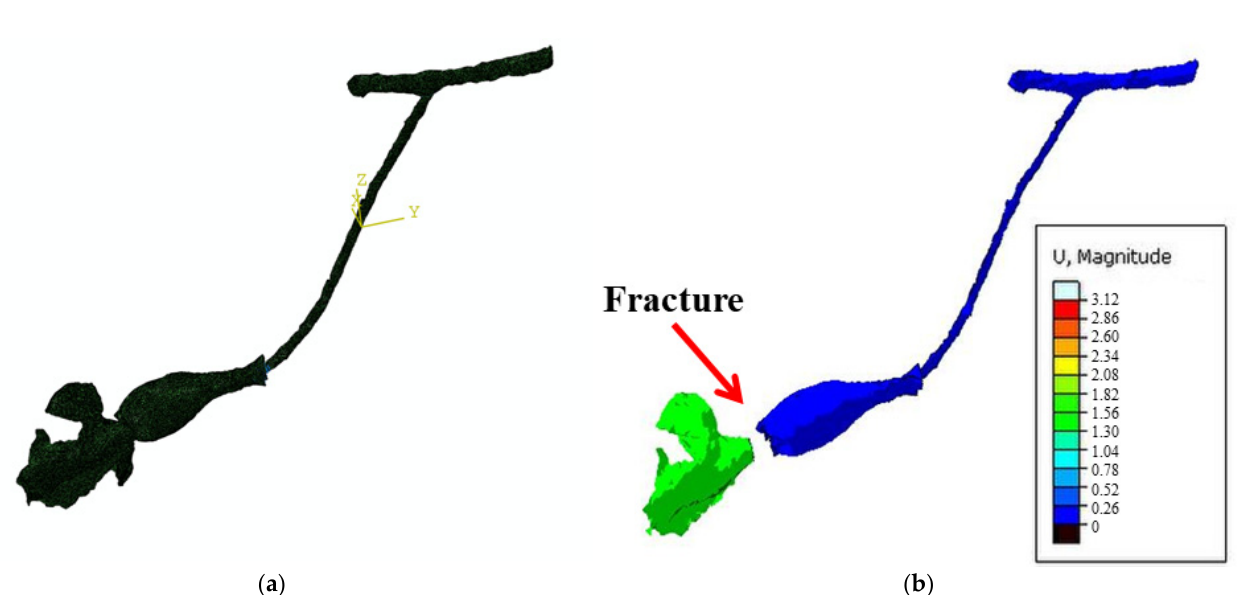
Figure 5. The meshed model ( a ) and the result ( b ) of the flower in the detachment simulation.